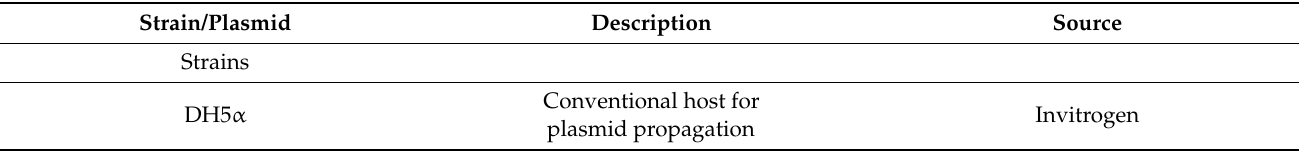
Table 1. Plasmids and E. coli strains used in this study. Strain/Plasmid